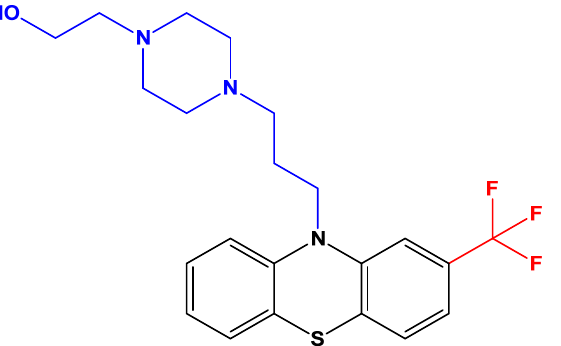
Figure 1. Chemical structure of fluphenazine. This drug consists of a phenothiazine ring system, with a piperazine side chain (represented in blue) attached to the nitrogen in the para-thiazine ring and a trifluoromethyl group (represented in red) attached to the second benzene ring. The structure was obtained using ChemDraw software (version 12.0, PerkinElmer, Inc., Waltham, MA, USA). Fluphenazine acts on the postsynaptic dopaminergic D1 and D2 receptors in the brain, inhibiting the release of hormones such as dopamine from the hypothalamus and from the hypophysis, which in turn affects different body functions such as basal metabolism, body temperature, wakefulness, vasomotor tone, etc., [16], that can result in CNS side effects